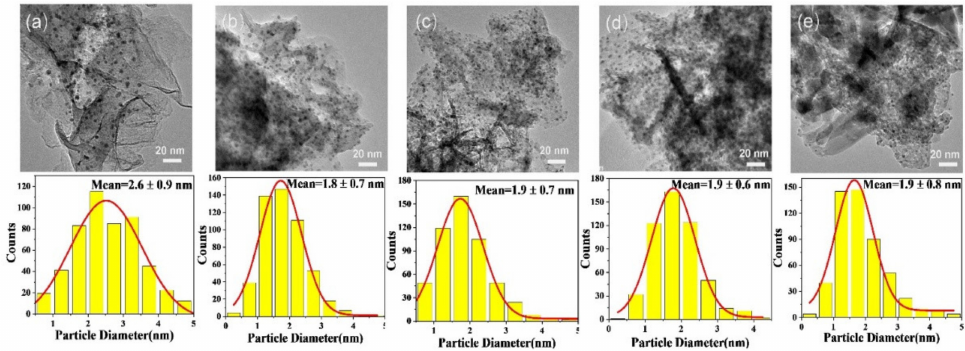
Figure 4. TEM images of Zn-Mg-Al mixed oxides-supported gold catalysts: ( a ) Au 25 /MgAl-400; ( b ) Au 25 /Zn 0.05 MgAl-400; ( c ) Au 25 /Zn 0.33 MgAl-400; ( d ) Au 25 /Zn 3 MgAl-400; ( e ) Au 25